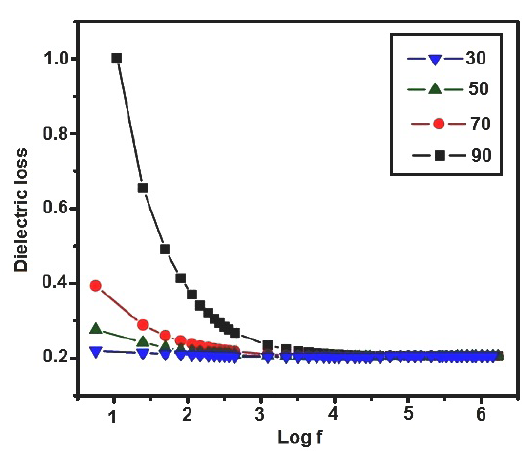
Fig.9. Dielectric loss of Zn-doped SnO